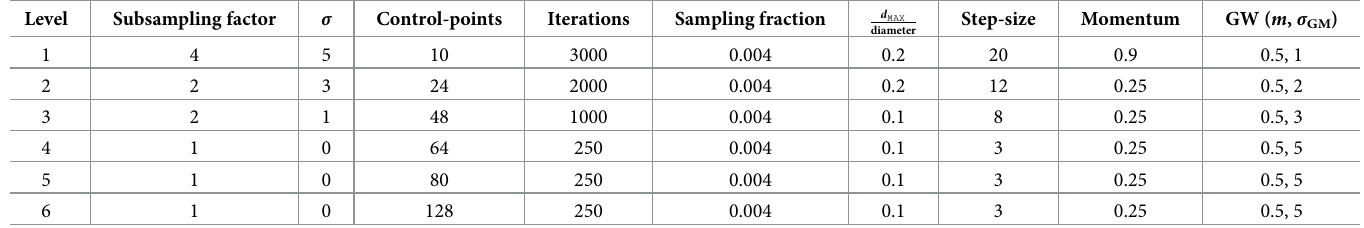
Table 1. INSPIRE parameter configuration for evaluation on retinal images. For all levels: λ = 0.005, N α = 7, normalization percentile q = 0.025% and histogram equali- zation disabled. KD-tree search approximation constants are chosen as β = 1.2 and d t = 20. Level